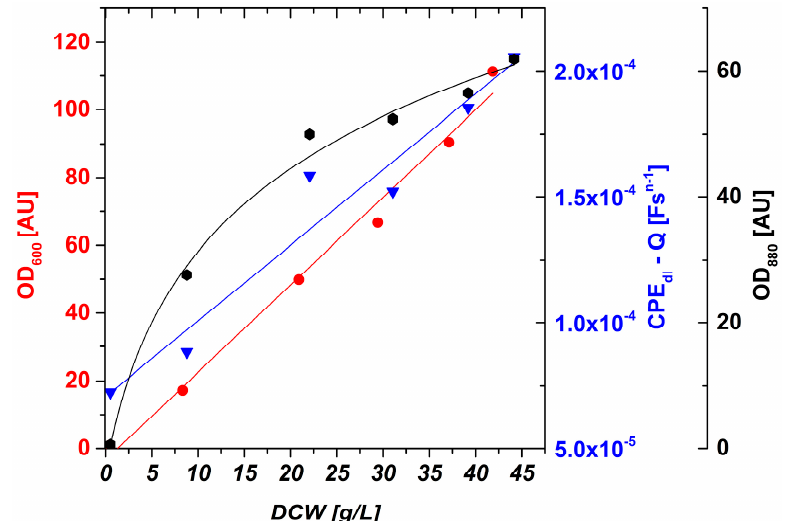
Figure 5. OD 600 offline, OD 880 inline and impedance online (CPE dl -Q) signals as a function of DCW.